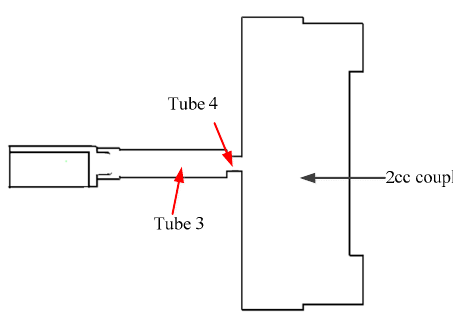
Figure 5. Acoustic modeling in the test jig.